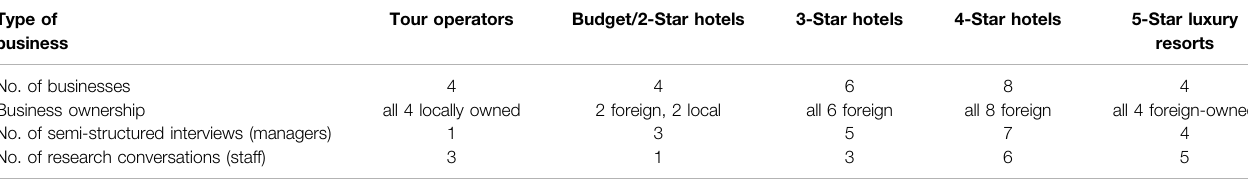
TABLE 1 | Tourist businesses selected for the study, number of interviews and research conversations, and business ownership structure. Source: Author ’ s own. Type of